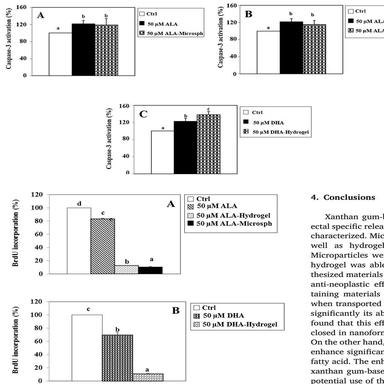
Effect of a 48 h treatment with 50 μM ALA in its free form or delivered by xanthan gum-based microspheres and hydrogel (A) and of 50 μM DHA in its free form or delivered by hydrogel (B) on cell proliferation evaluated as BrdU incorporation in HCT116 cells. Data are the means ± SD of three different experiments. Values not sharing the same superscript are significantly different (p < 0.05, one−way ANOVA followed by Tukey's test).